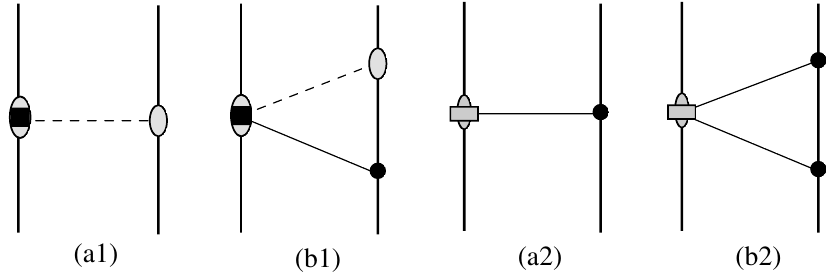
Figure 5 . The Feynman graphs of one- and two-graviton exchange from composite worldline couplings that appear at the NLO quartic-in-spin interaction. These graphs with the composite couplings, that are cubic and quartic in the spin, yield similar graphs to the corresponding ones with the elementary spin-induced octupole and hexadecapole in figure 2(b1), (c1), and figure 3(a1), (b1). where all the indices are in the locally flat frame, and the canonical gauge is applied.